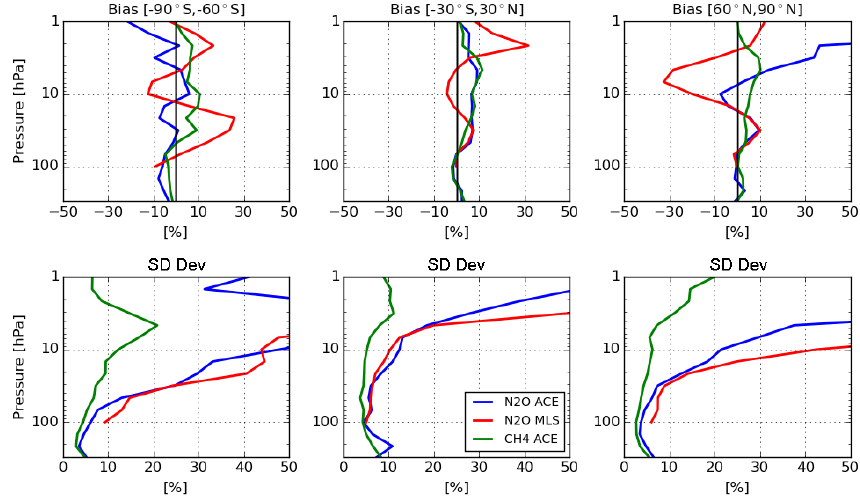
Figure 8. Mean (top) and standard deviation (bottom) of (ENS − independent_data) / independent_data where independent_data is ACE– FTS N 2 O (blue line), ACE–FTS CH 4 (green line) or MLS N 2 O (red line) for the period September–October 2008 and for three latitude bands (from left to right: South Pole, tropics and North